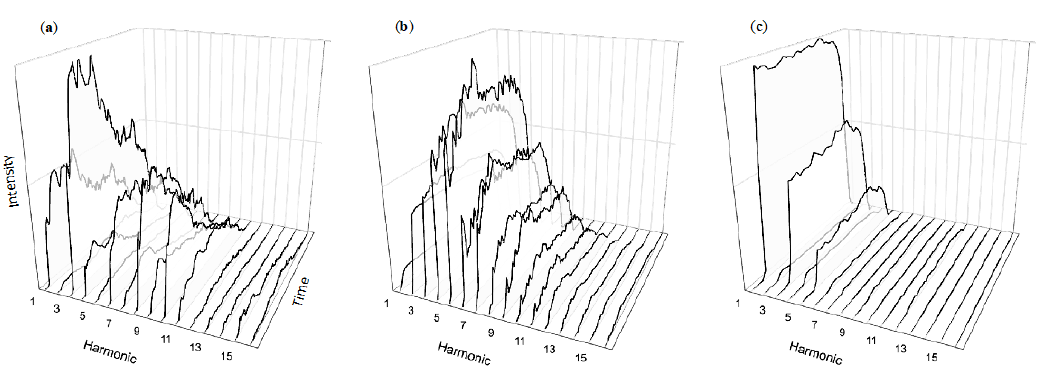
Figure 2. Musical instrument tones feature complex temporal changes simultaneously at multiple harmonics. Although notes from the violin ( a ), trumpet ( b ), and clarinet ( c ) differ in their specific temporal changes, they all exhibit temporal complexity.